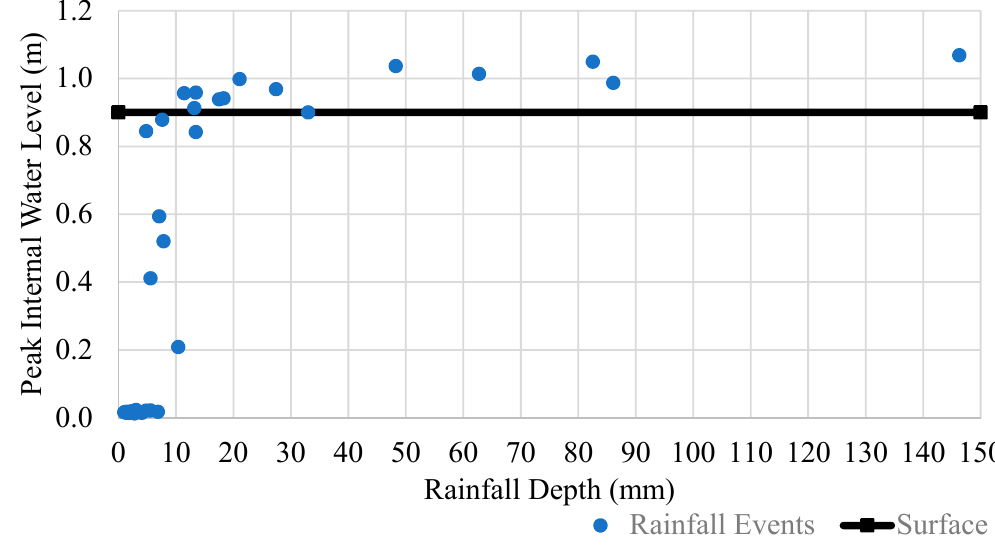
Figure 7. Positive association ( α = 0.05) between the rainfall depth and the peak bioswale internal water level. Events above the black line (surface) represent surface ponding.